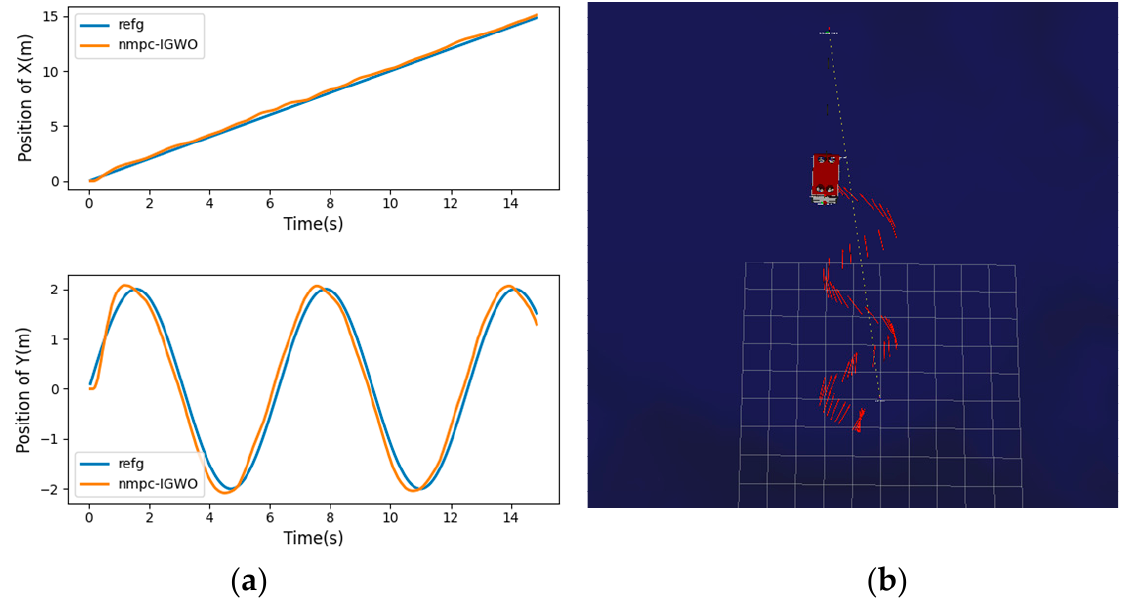
Figure 8. case II trajectory tracking effect: ( a ) case II x/y state tracking effect; ( b ) case II XOY plane tracking effect.